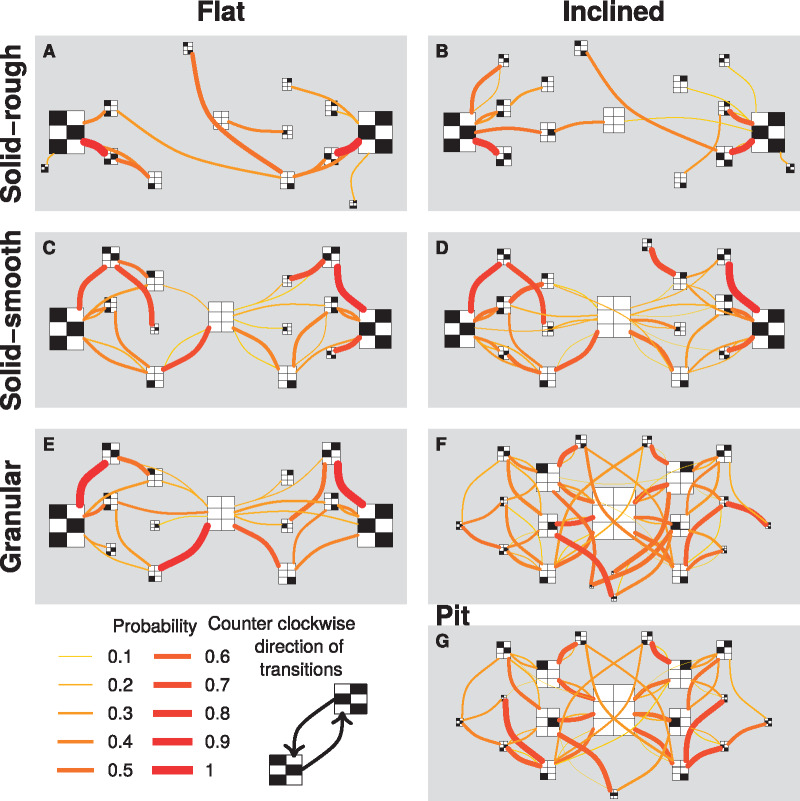
Ethograms of leg configurations by treatment. Legs are either in stance or in swing state represented by white or black blocks, respectively. The head is pointing upward. The surface of each rectangle (composed of six white or black blocks representing the legs) is proportional to the observed frequency of each gate pattern (i.e., bigger rectangles mean a bigger time spent by ants performing that type of gate pattern). The lines between different gate patterns show the probability to shift from one to the other. Linewidths indicate higher or lower probabilities (see the figure legend) and the direction of the transitions should be considered counter clockwise according to the line curvatures. Gate pattern transitions are indicated only if at least five transitions were observed and if the probability was >5%.